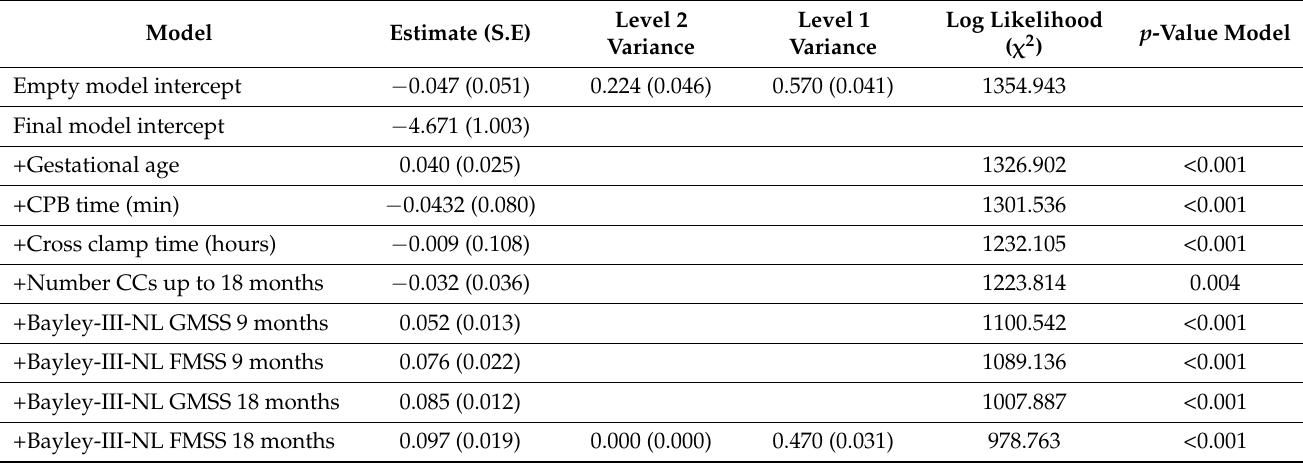
Table 3. Final multilevel model predicting total motor